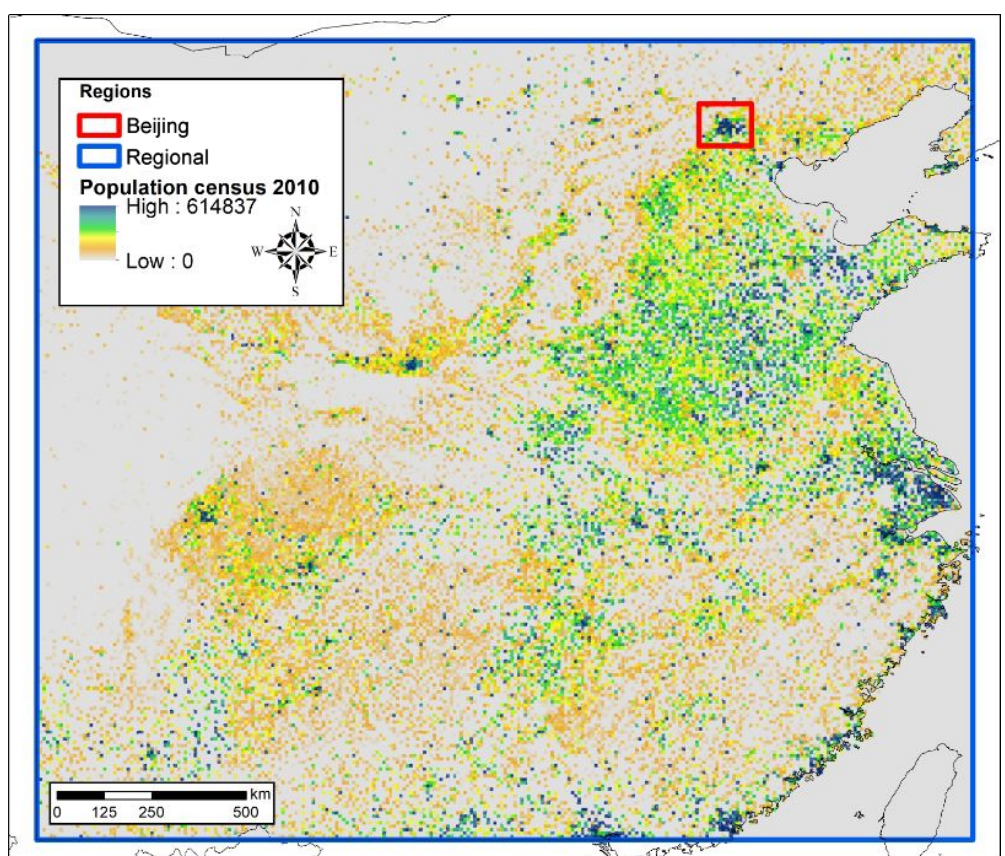
Figure 4. The blue box represents the regional contributions from outside Beijing and the red box is the Beijing region. The map also shows the 2010 population census (people per pixel – WorldPop data,